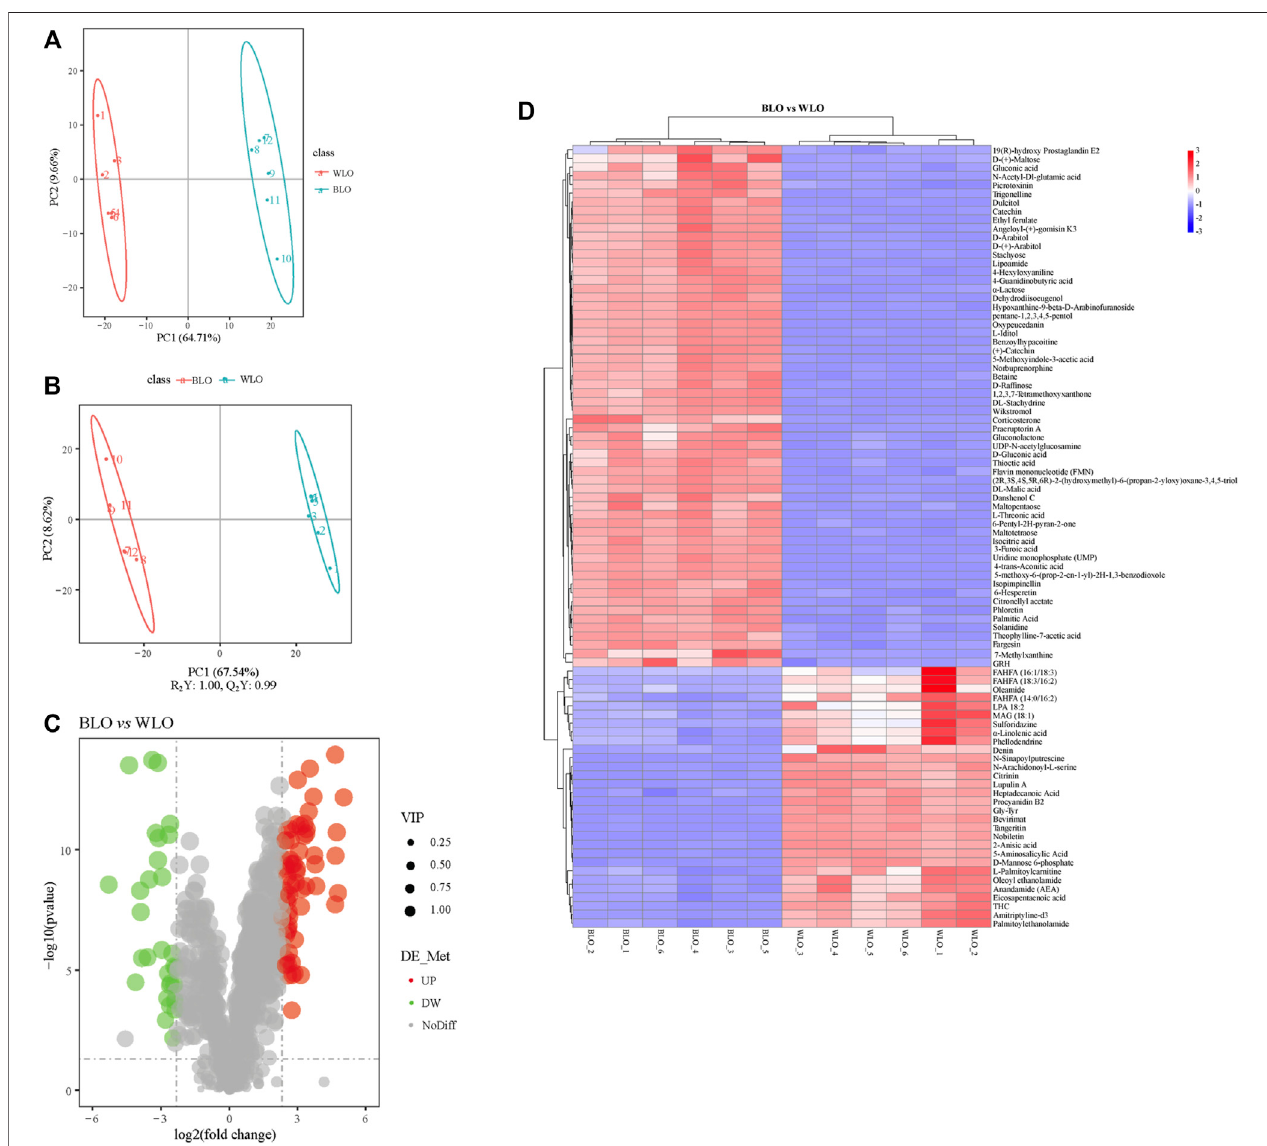
FIGURE 4 | Untargeted metabolomics studies by UPLC-MS/MS on the secondary metabolites composition of BLO and WLO. (A,B) : Multivariate data analysis of UHPLC-MS data of BLO and WLO. PCA (A) and OPLS-DA (B) score plots derived from the UPLC-MS/MS data of BLO and WLO metabolite pro fi les. Volcano plot (C) and Heatmap (D) used to visualize the different metabolites in BLO compared to WLO.